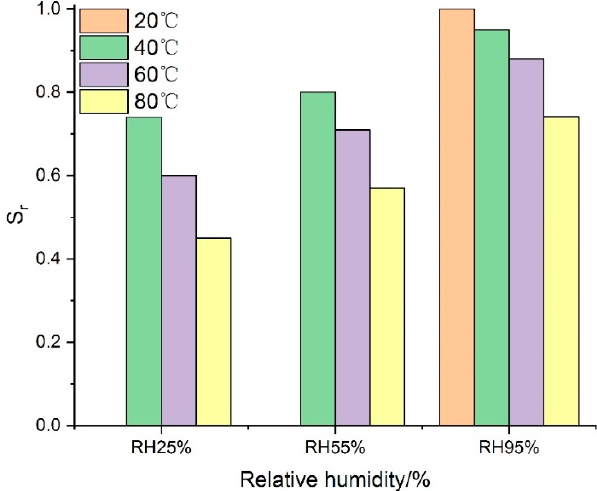
Figure 9. The influence of temperature and RH on Sr.